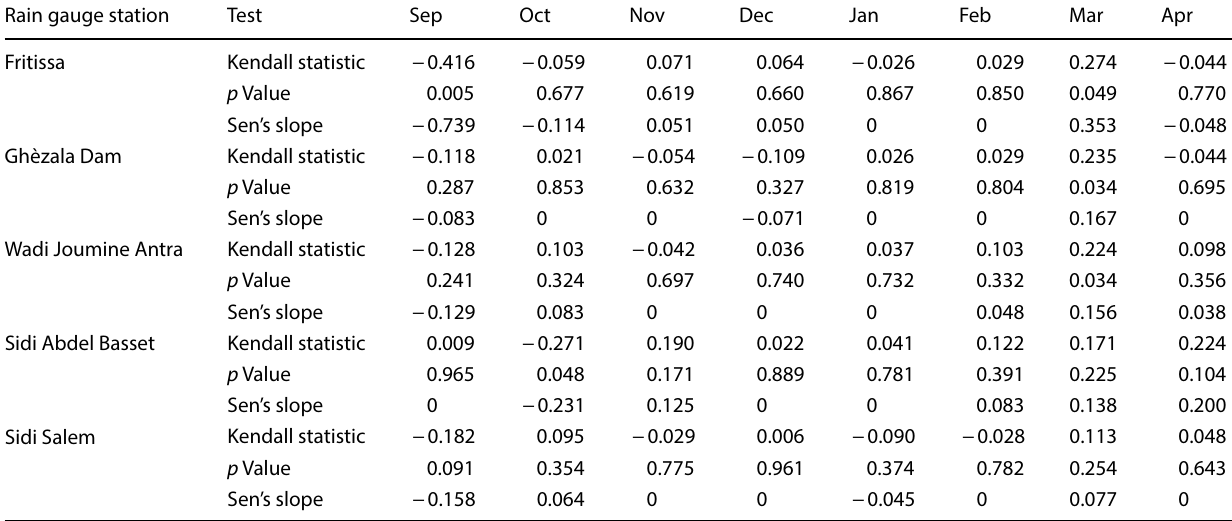
Table 9 Trends in the monthly extreme dry spell length. Signification level (%): 5, (Sen’s slope): 95% Rain gauge